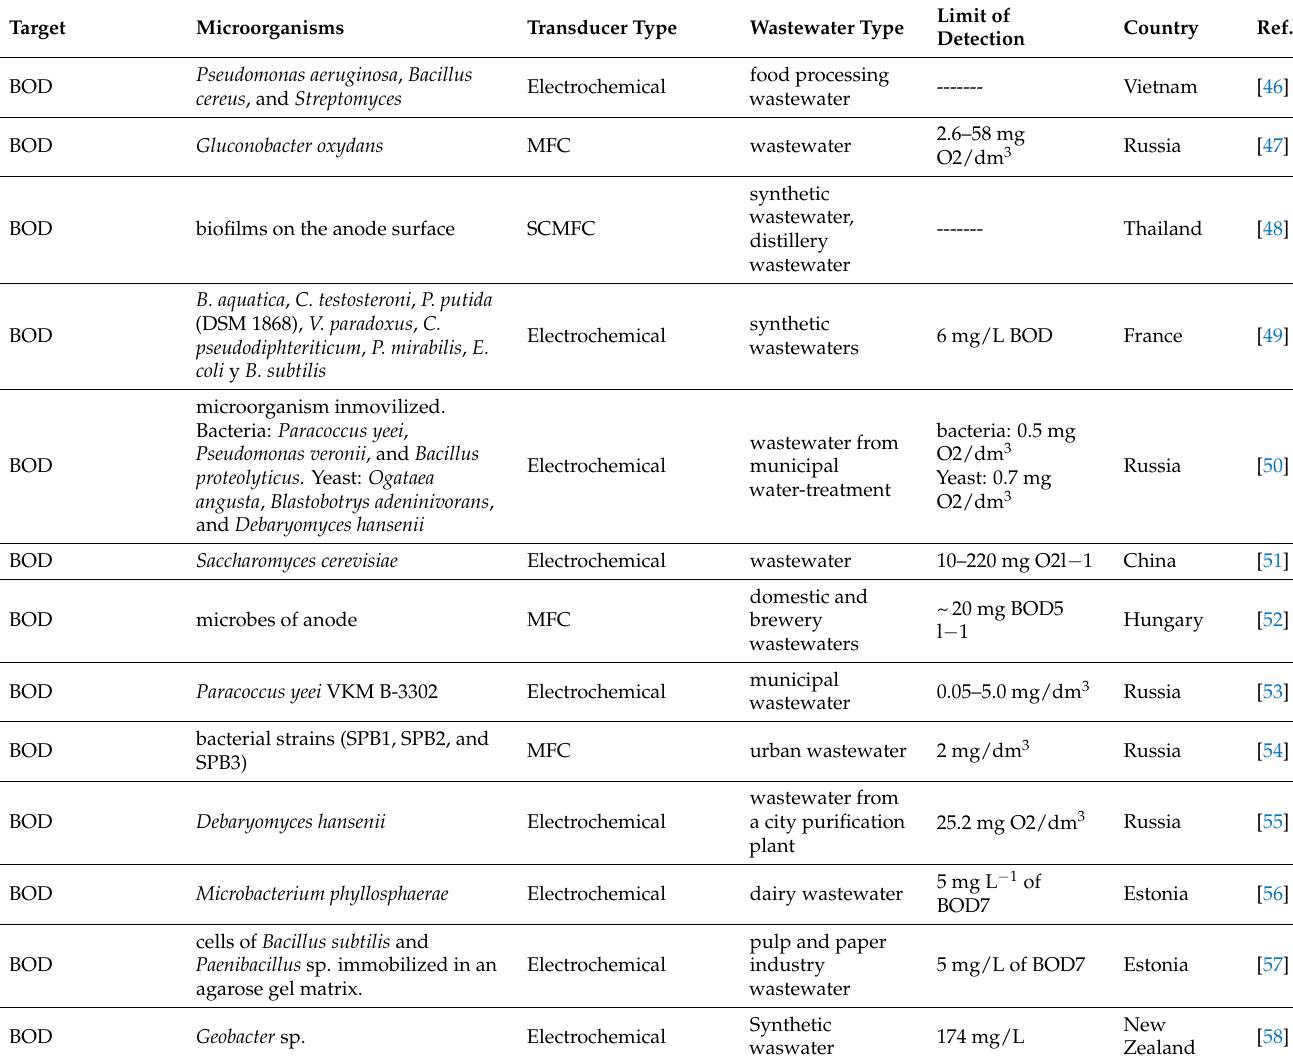
Table 2. Microbial biosensors tested in wastewater reported in articles during the period